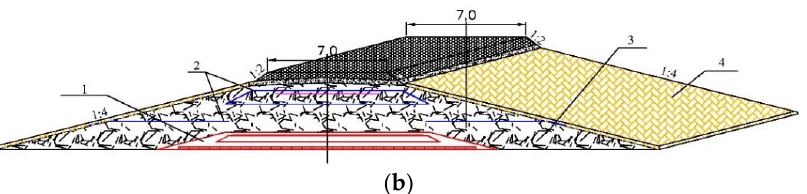
Figure 3. Building of a haul road: ( a ) executing works; ( b ) fitting the haul road into the embankment transverse profile (1—haul road, 2—geotextile holder, 3—embankment, 4—peat sand mix).